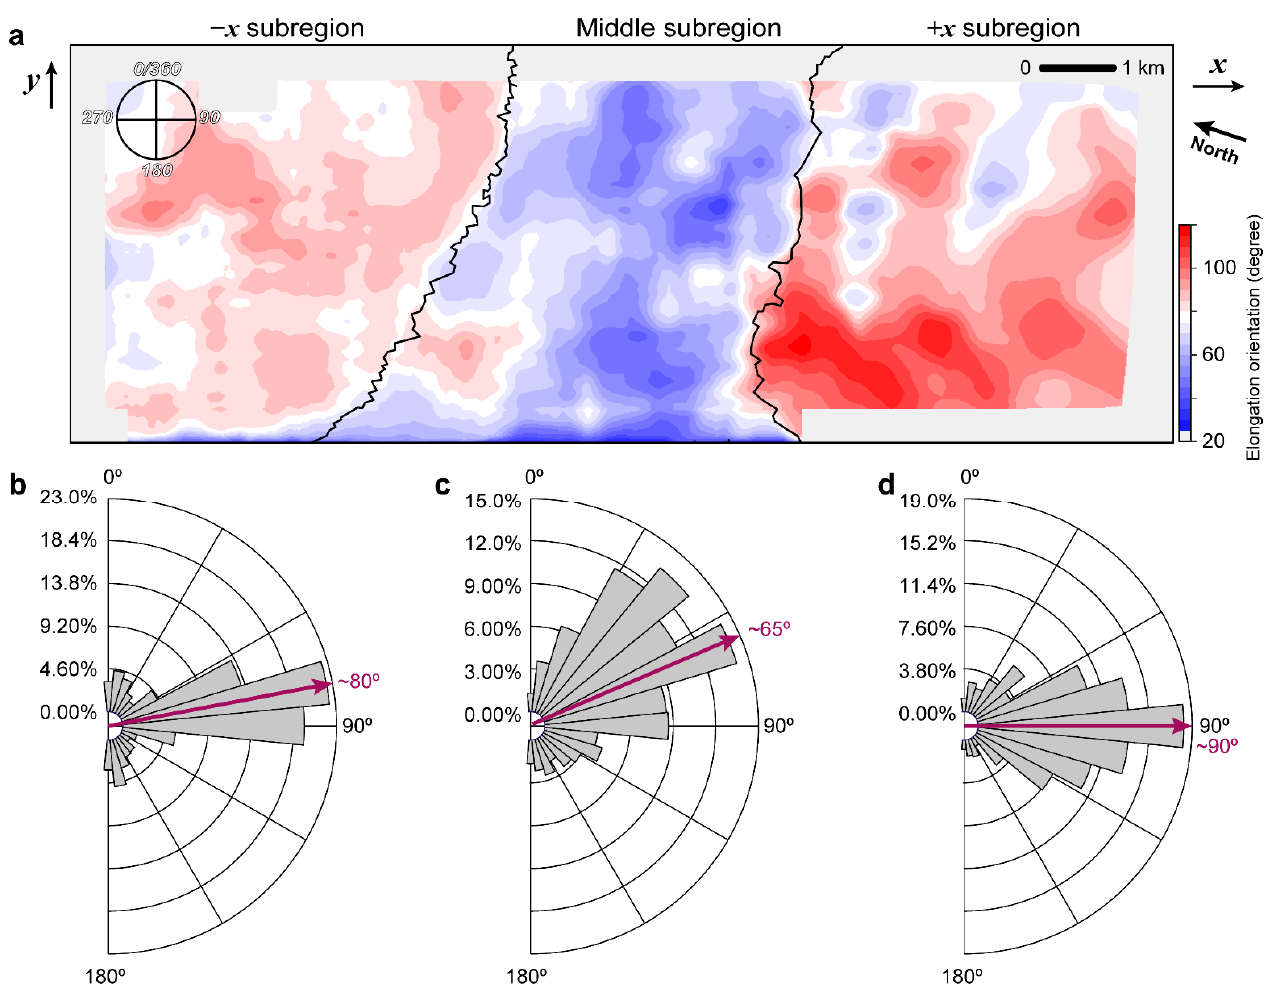
Figure 4. The analysis distribution of elongation orientation of the polygons. ( a ) Distribution of elongation orientation of the polygons in three subregions. ( b – d ) Windrose plots of elongation orientations in the three subregions. Dominate elongation orientations are marked with arrows.